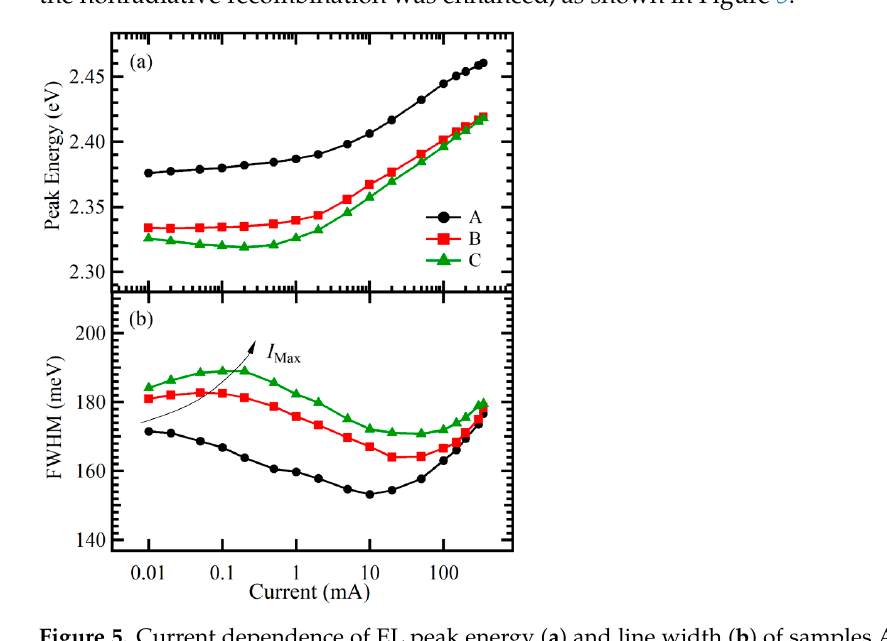
Figure 5. Current dependence of EL peak energy ( a ) and line width ( b ) of samples A, B, and C at 300 K. The critical currents I Max , corresponding to the initial minimum of the line width, are shown by an arrow as a guide to the eye.